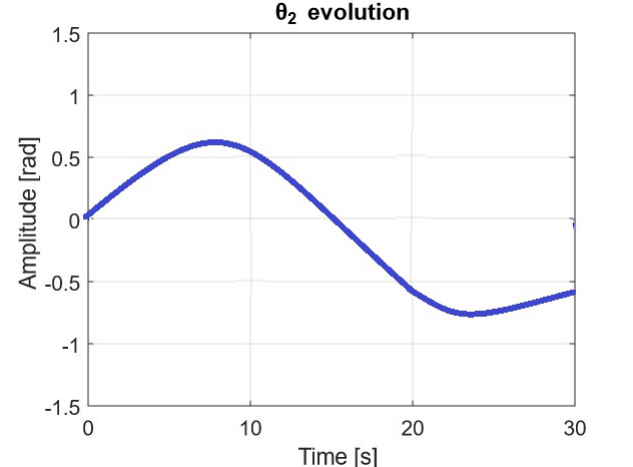
Figure 8. Swing angle θ 2 of the second pendulum along time achieved by the PD-PD control system.